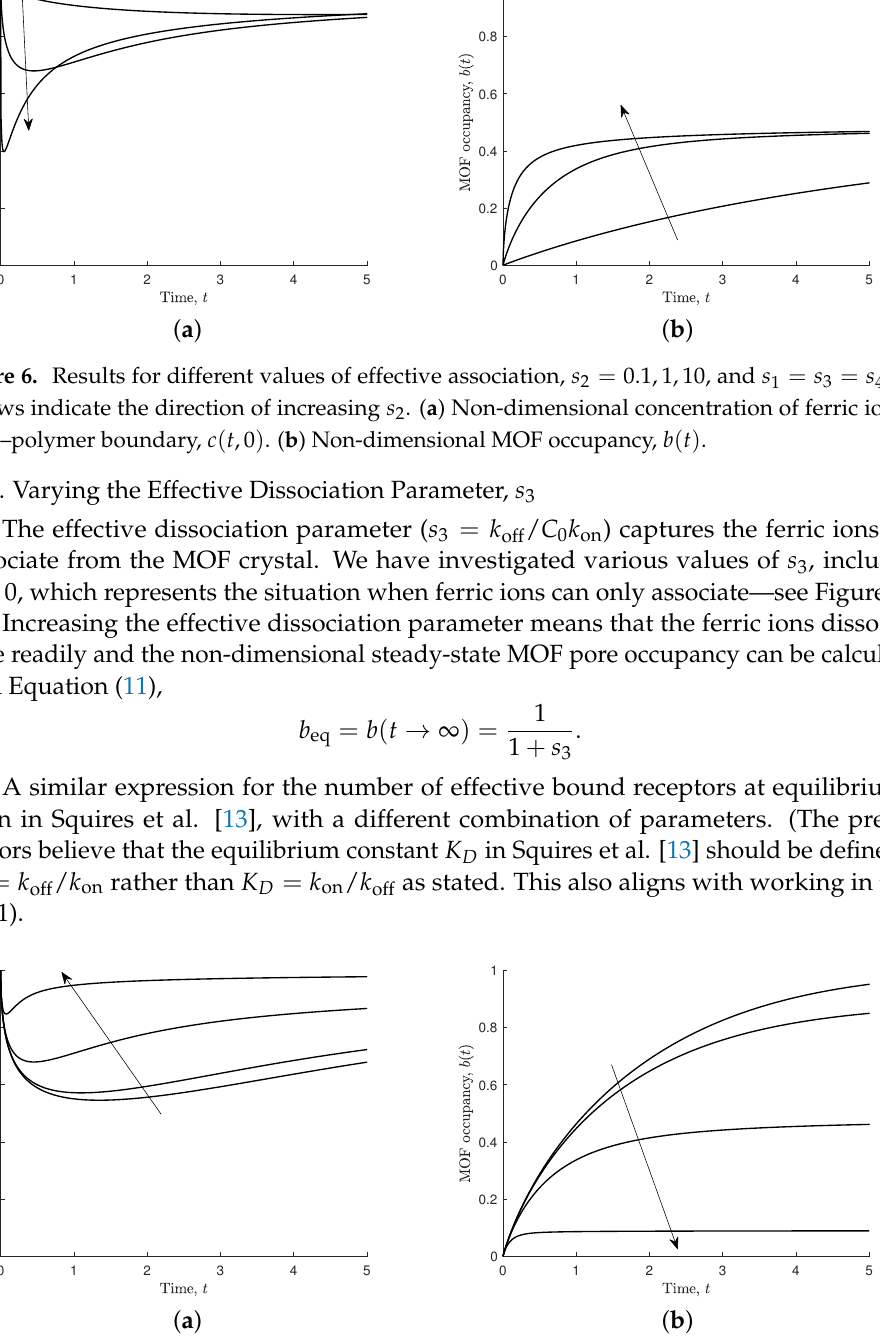
Figure 7. Results for different values of effective dissociation, s 3 = 0,0.1,1,10, and s 1 = s 2 = s 4 = 1. Arrows indicate the direction of increasing s 3 . ( a ) Non-dimensional concentration of ferric ions at MOF–polymer boundary, c ( t ,0 ) . ( b ) Non-dimensional MOF occupancy, b ( t )